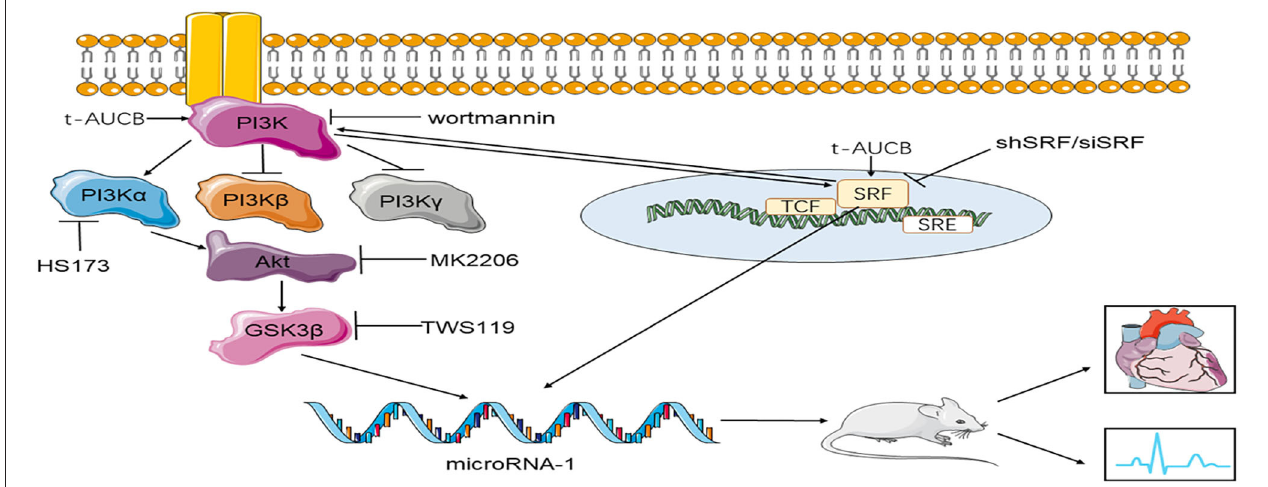
FIGURE 5 | The mechanism of t-AUCB regulation of ischemic arrhythmia. T-AUCB, a preparation of sEHis, regulates microRNA-1 by regulating SRF and the PI3K α /Akt/GSK3 β pathway, thereby reducing the size of myocardial infarction and inhibiting ischemic arrhythmias. During this process, the PI3K α /Akt/GSK3 β pathway and SRF interact with each other. SRF indicates serum response factor; shSRF indicates SRF small hairpin; siSRF indicates SRF small interfering RNA; wortmannin is the inhibitor of PI3K; HS173 indicates PI3K α inhibitor; MK2206 is the inhibitor of Akt; TWS119 is the inhibitor of GSK3 β